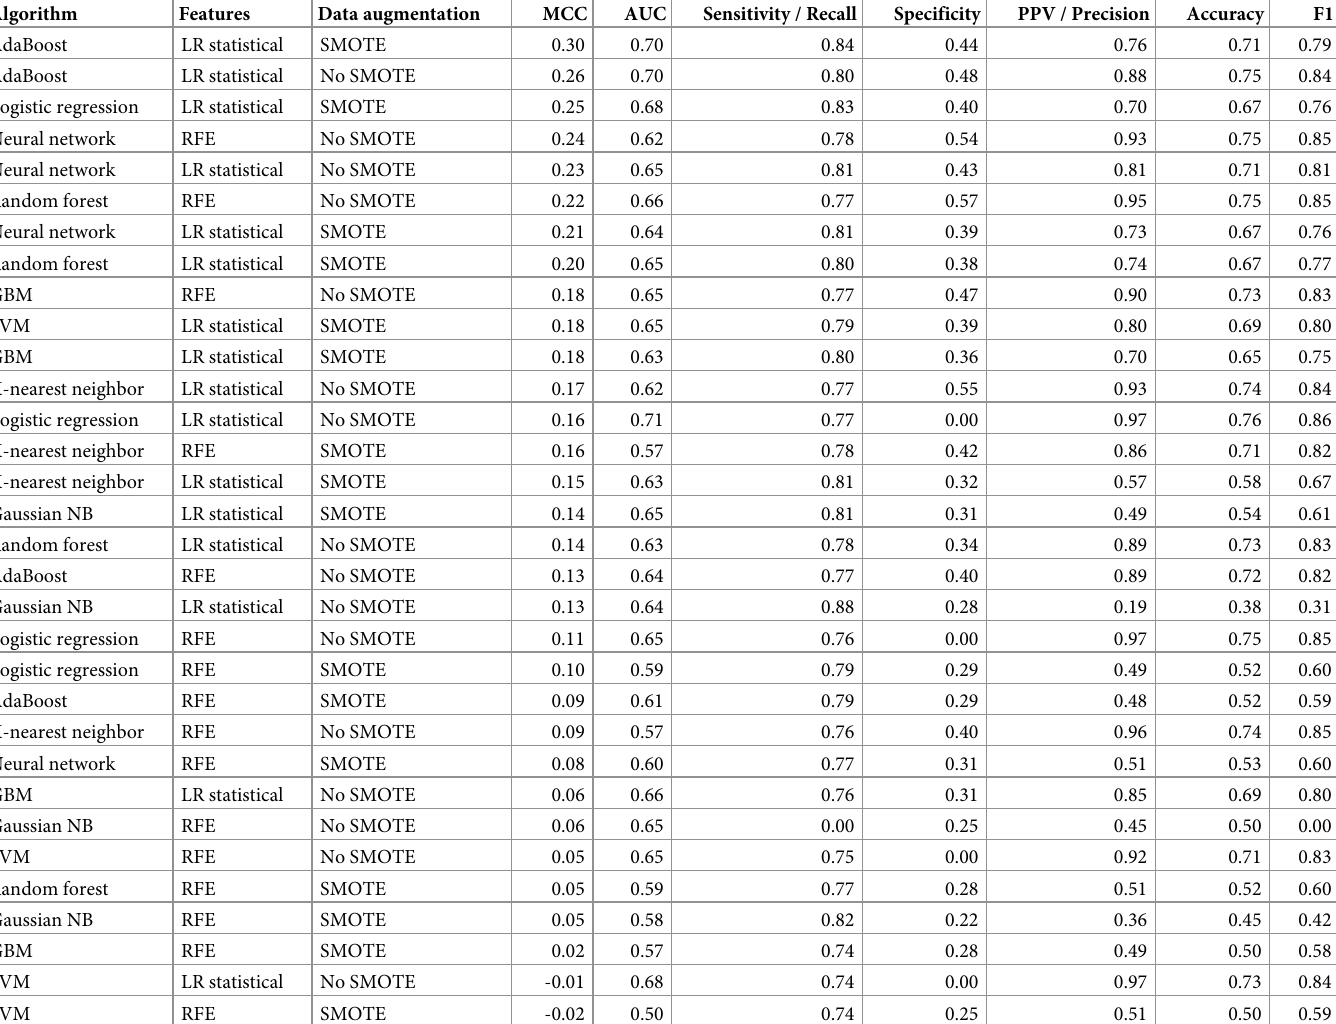
Table 4. Mean 5-fold cross-validation algorithm performance results, sorted by MCC. SMOTE was applied to the training dataset only. GBM, gradient boosting machine. LR, logistic regression. NB, na ï ve Bayes. RFE, recursive feature elimination. SMOTE, synthetic minority oversampling technique. SVM, support vector machine. Algorithm